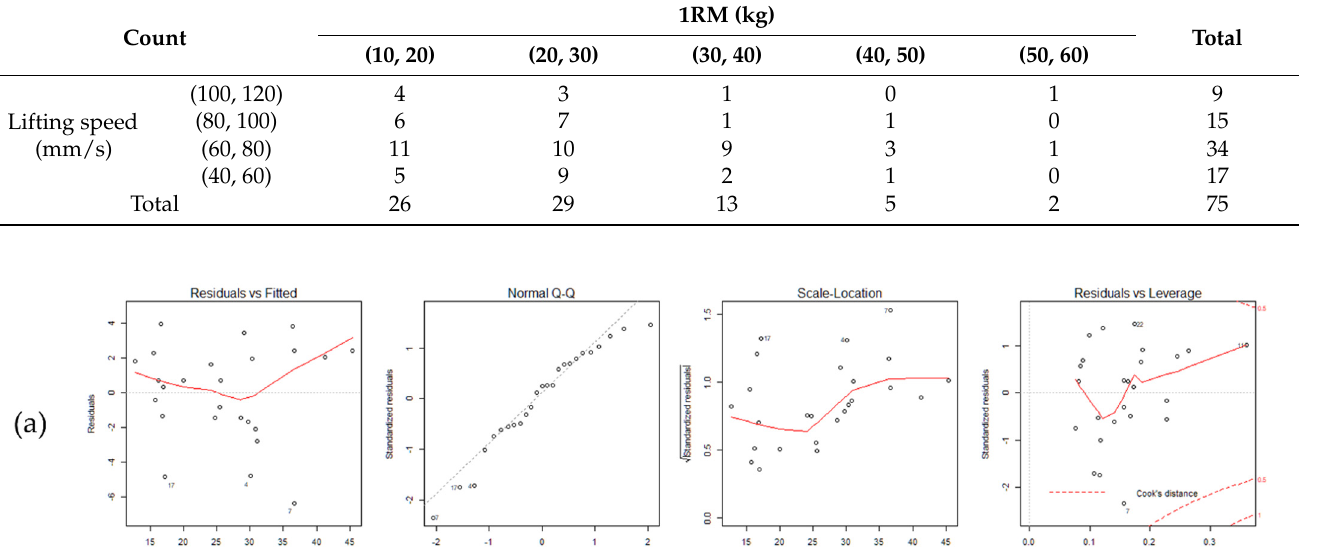
Table 5. Frequency table of 1RM and corresponding lifting speed using a hydraulic press machine.